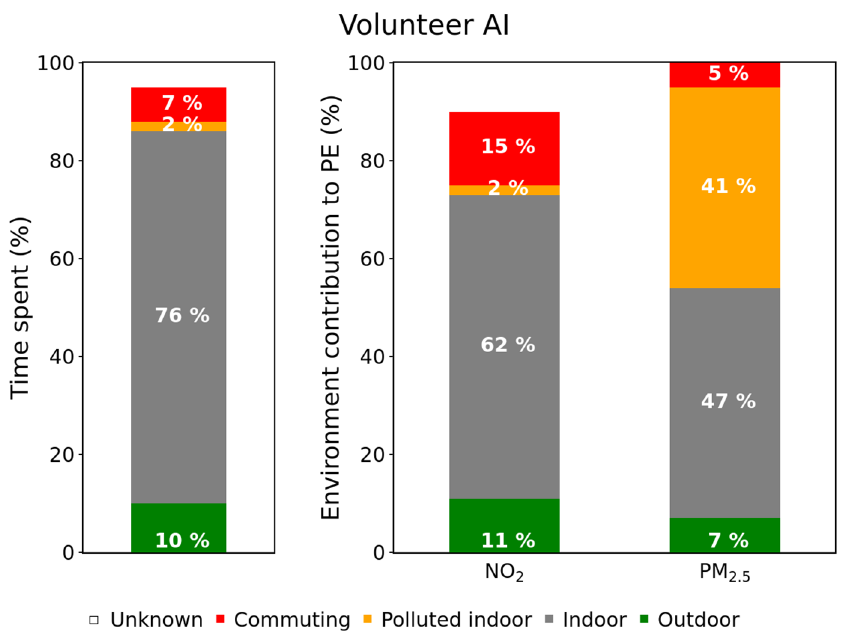
Figure 3. Time spent in each visited environment (left hand bar) and environment contribution to the total PE (volunteer AI, spring campaign).